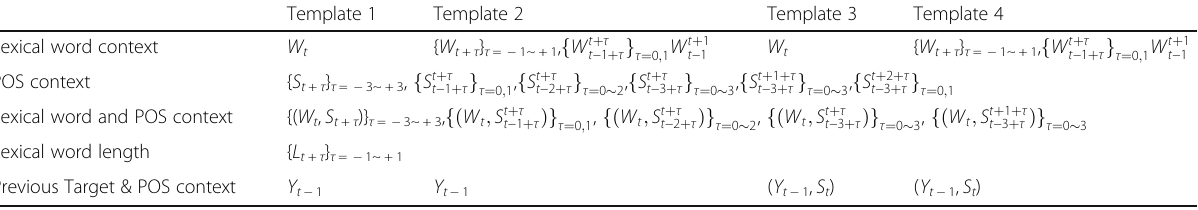
Table 8 Feature templates for PC. The notation represents a sequence: W t − l , W t − l +1 … W t … W t + u − 1 , W t +